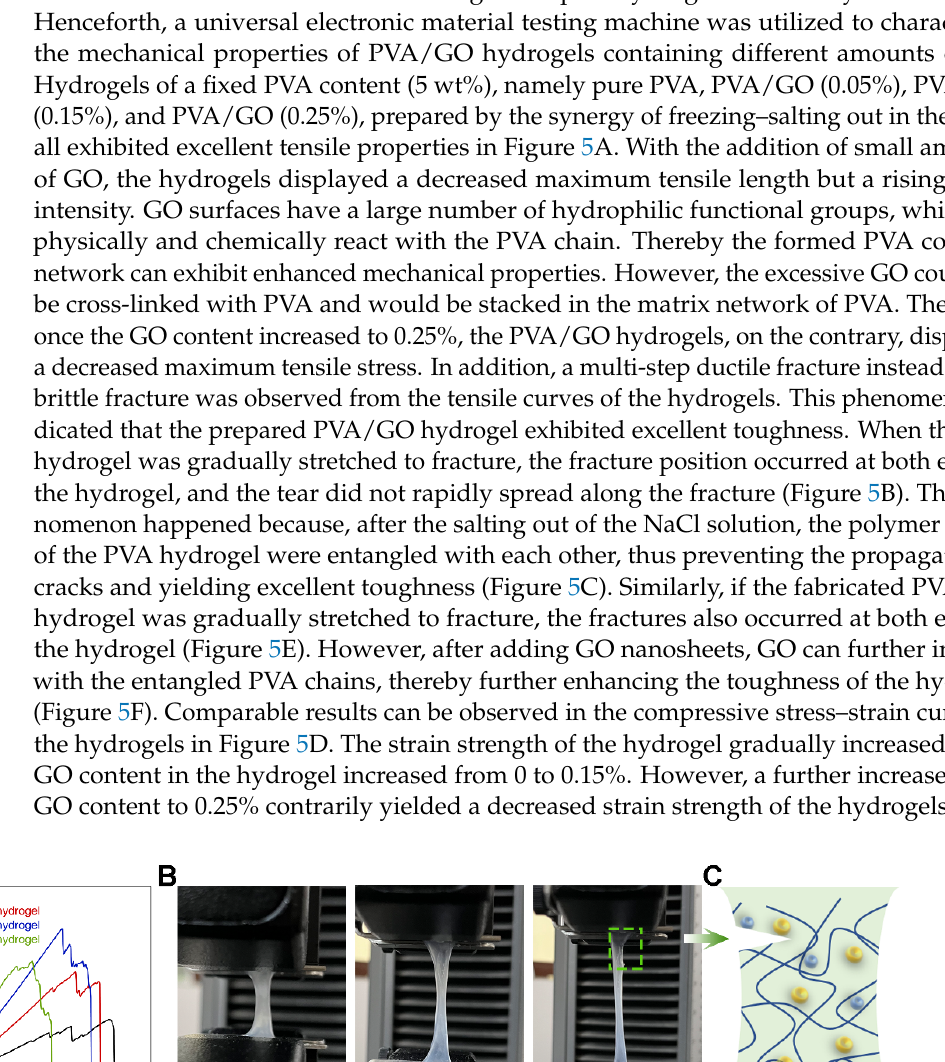
Figure 4. Chemical composition analysis of GO, PVA hydrogel, and PVA/GO hydrogel. ( A ) XRD patterns. ( B ) Raman spectra. ( C ) FTIR spectra. ( D ) TGA curves.